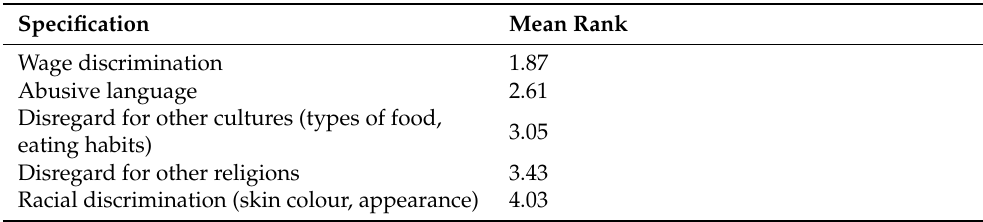
Figure 2. Chart depicting the reasons for willingness to recommend working for a Korean shipping company to their friends (n = 75). Table 6. Priority areas for addressing discrimination (n =